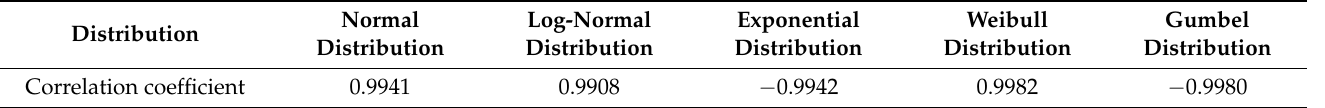
Figure 5. The frequency histogram and the cumulative frequency histogram of the time to cata- strophic failure and the most suitable distribution.